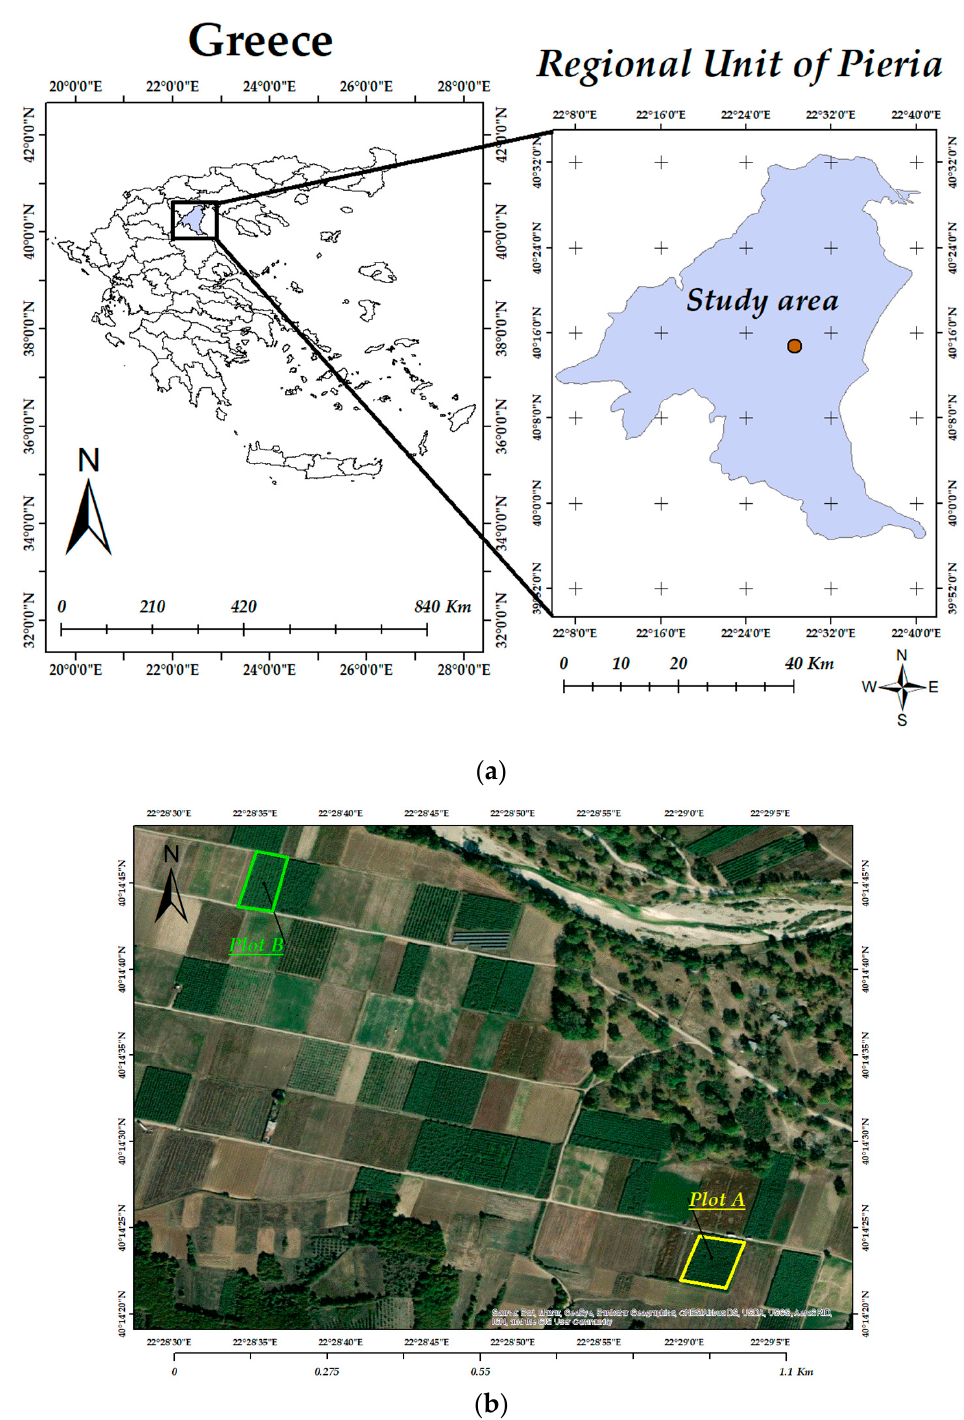
Figure 1. ( a ) Map of the study area; ( b ) kiwi orchards (plots A and B). The climate of the area is typical Mediterranean [40]. Monthly meteorological